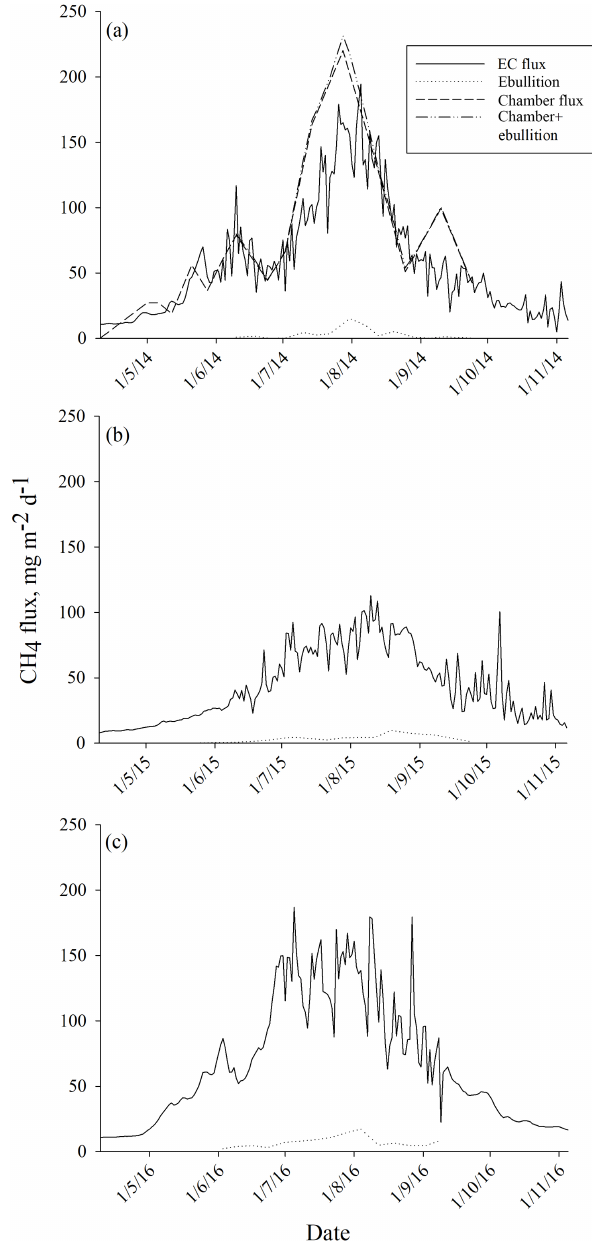
Figure 6. Ecosystem-level methane fluxes measured with the eddy covariance (EC) technique and upscaled from ebullition measure- ments in (a) 2014, (b) 2015 and (c) 2016. In 2014, ecosystem-level methane fluxes are also compared to upscaled chamber